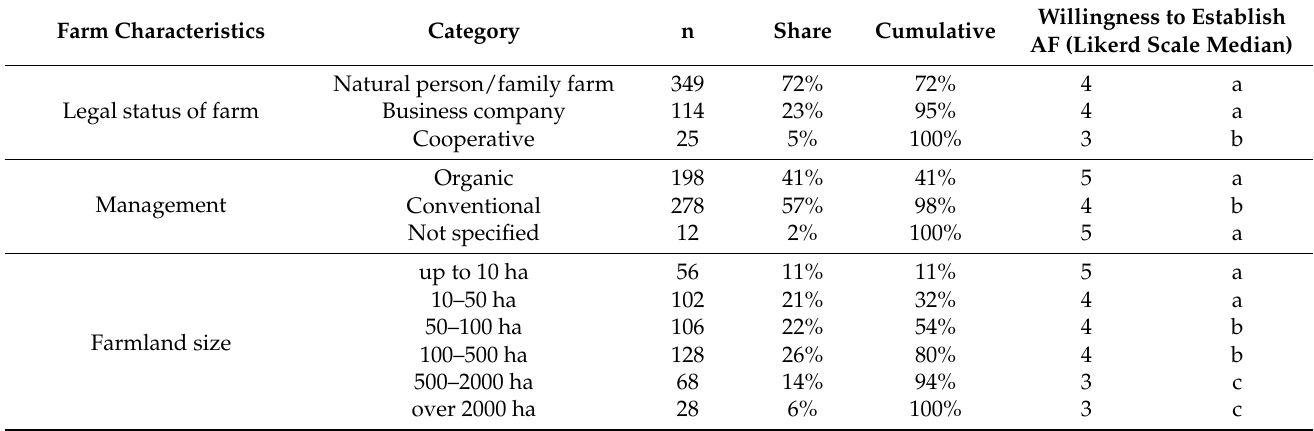
Table 2. Farm characteristics of the participants in farmers survey, together with the Likert scale median of the willingness to establish AF (medians followed by different letters are significantly different at p <